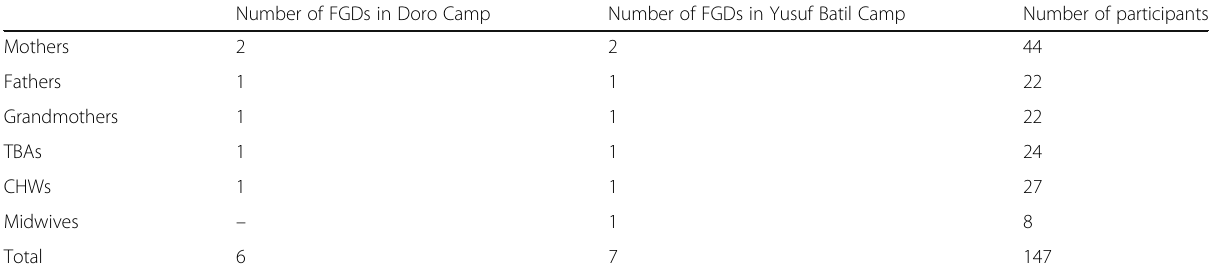
Table 2 Composition and location of focus group discussions